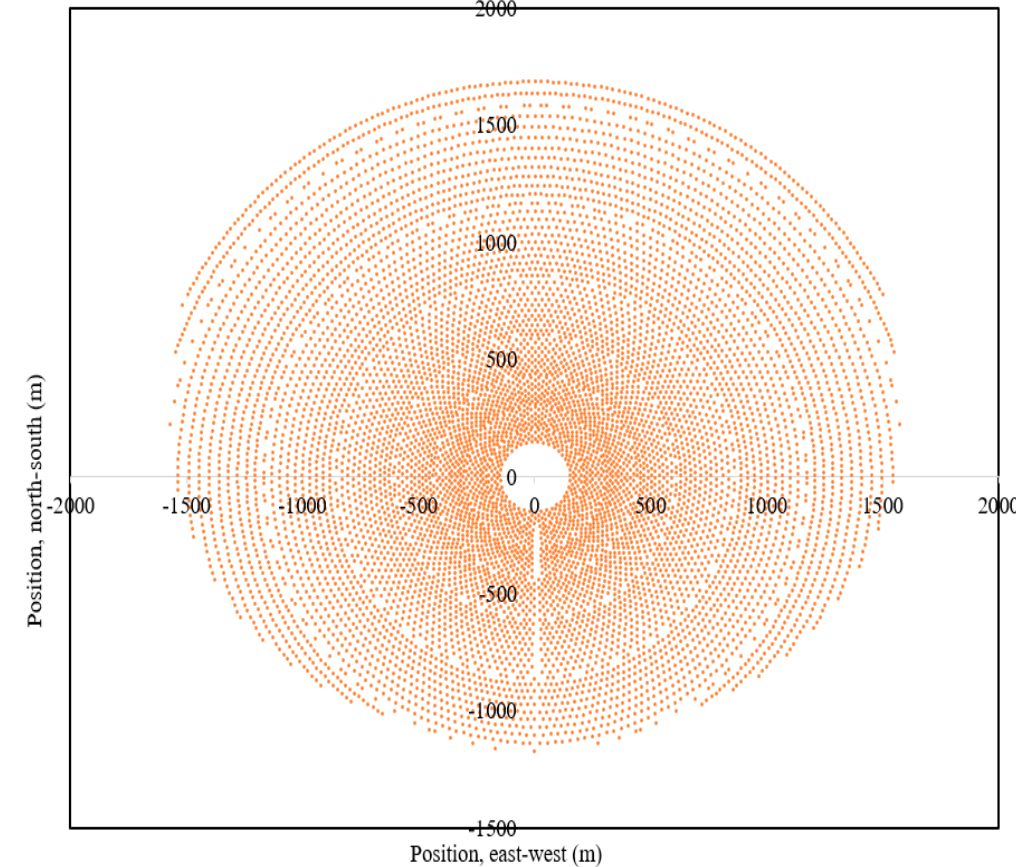
Figure 15. Heliostat field of the 50 MWe SPT plant. Table 7. Design characteristics and specifications of the 50 MWe SPT